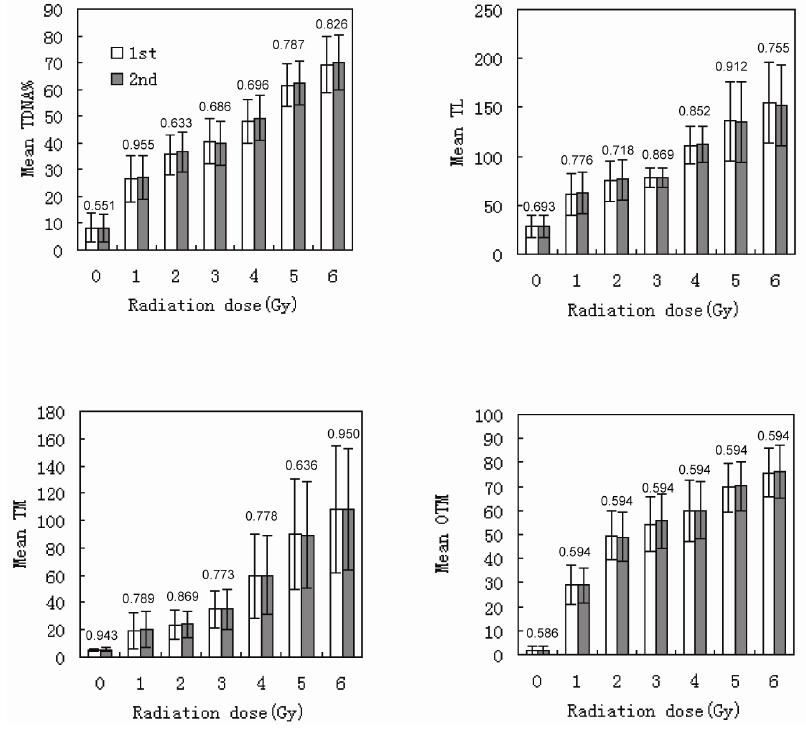
Figure 3. Variations in TDNA%, TL, TM, and OTM between the first and second experiments (the numbers above the column diagrams are p values between the first and second experiments; error bars: ±1.00